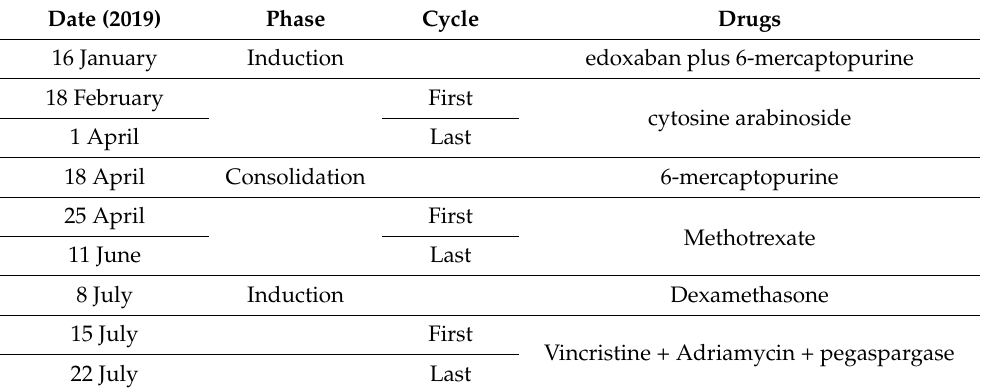
Table 1. Chemotherapy protocol used for acute lymphoid leukemia (EGIL B-II subtype). AEIOP